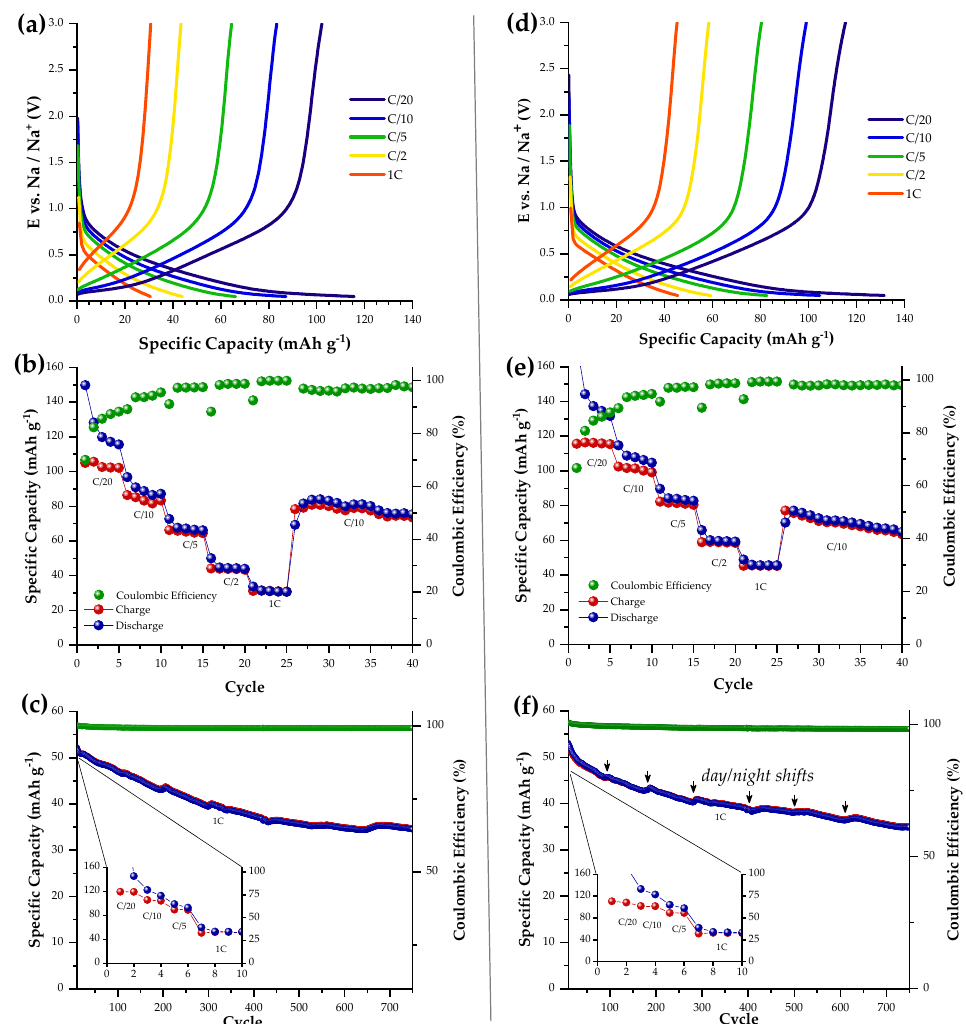
Figure 7. Galvanostatic cycling behavior of C-surgical ( a – c ) and C-FFP2 ( d – f ) with 1 M NaClO 4 in PC as electrolyte, in the 0.05–3 V vs. Na potential range: ( a , d ) Voltage vs. specific capacity profiles for selected cycles, one per current regime: C/20 (0.025 mA/cm 2 ), C/10 (0.05 mA/cm 2 ), C/5 (0.1 mA/cm 2 ), C/2 (0.25 mA/cm 2 ) and 1C (0.5 mA/cm 2 ); ( b , e ) Specific capacity and coulombic efficiency as a function of cycles at the five different current regimes; ( c , f ) Specific capacity and coulombic efficiency upon prolonged cycling at 1C; steps in the profiles were due to temperature oscillations upon day/night shifts.